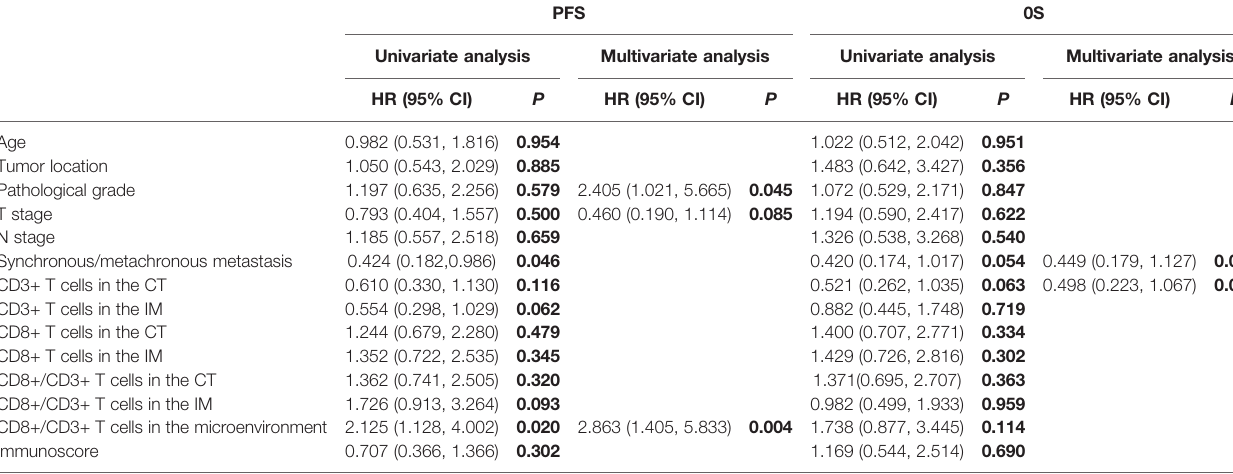
TABLE 5 | Univariate and multivariate analyses of immune cell in fi ltration and clinicopathological factors on survival for patients on chemotherapy regimens. PFS 0S